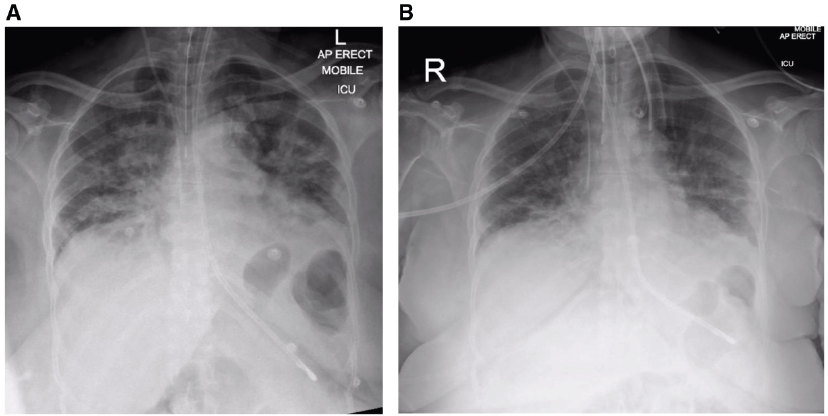
Figure 1. Case 1 radiographs. ( A ) Post-intubation plain chest radiograph, on ICU on day 5 post-onset of symptoms. ( B ) Plain chest radiograph on day 10 post-onset of symptoms.